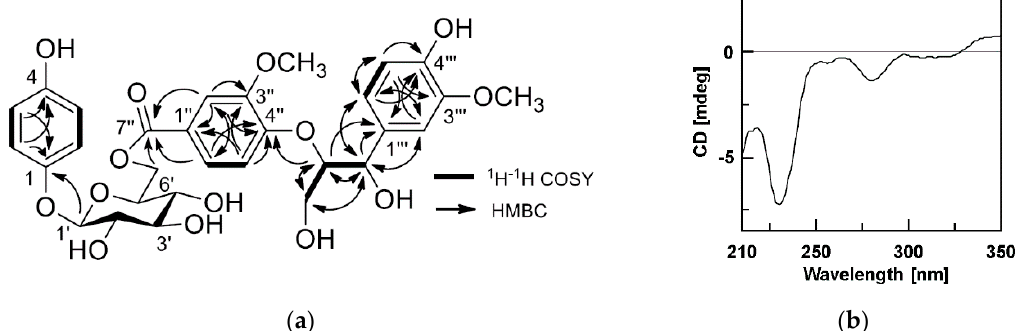
Figure 2. ( a ) 1 H ‐ 1 H COSY and HMBC correlation of compound 1; ( b ) circular dichroism (CD) spectrum Figure 2. ( a ) 1 H- 1 H COSY and HMBC correlation of compound 1 ; ( b ) circular dichroism (CD) spectrum of compound 1. of compound